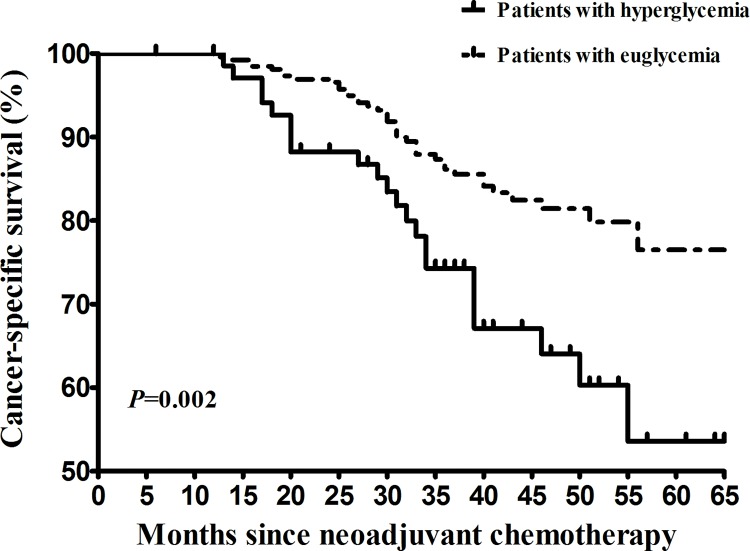
Kaplan–Meier survival curves for recurrence-free survival of cervical cancer patients receiving neoadjuvant chemotherapy for bulky early stage disease.The P values were determined by the log-rank test.